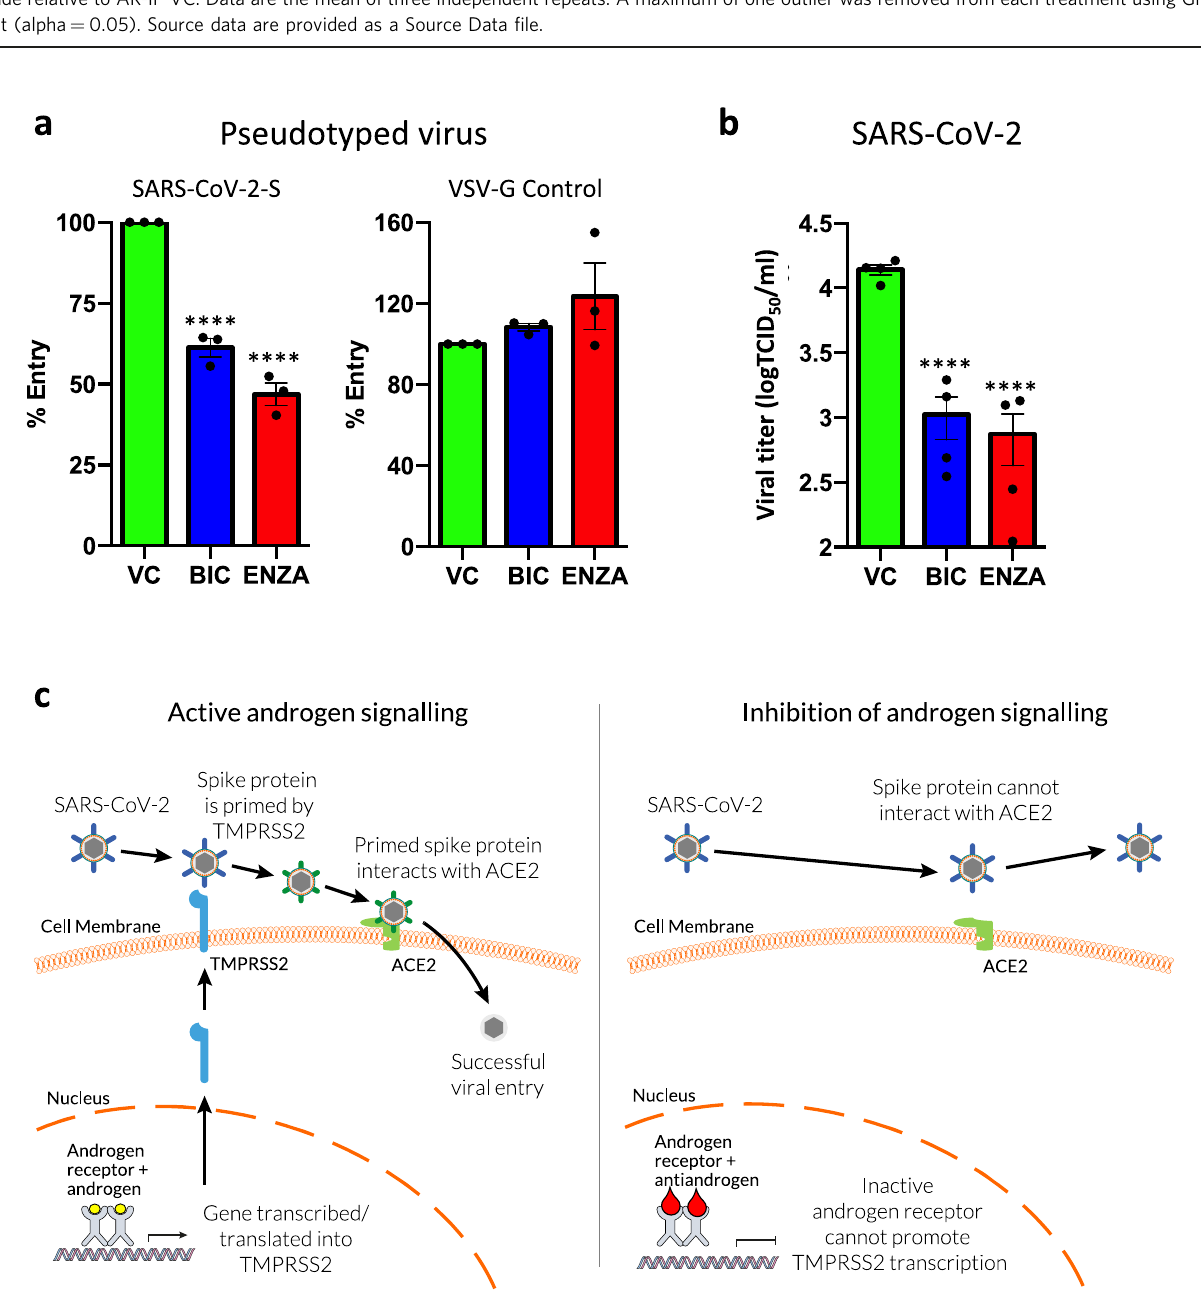
Fig. 7 Antiandrogens reduce SARS-CoV-2 entry and infection in lung cells. a A549 cells were seeded in full media and treated with ±10 μ M bicalutamide (BIC) or enzalutamide (ENZA) for 72 h prior to transduction with SARS-CoV-2 Spike protein or VSV-G control pseudotyped lentiviral particles expressing luciferase. Cells were left for an additional 48 h and luciferase assays performed. Luciferase data were normalised to total protein content. Mean of three independent repeats ± 1 SE. One-way ANOVA with Sidak ’ s multiple comparison test. Vehicle Control (VC) v BIC p = 1.3 × 10 − 4 , VC v ENZA p = 2.1 × 10 − 5 . b A549 were seeded in full media, transfected with ACE2 and treated with ±10 μ M BIC or ENZA for 72 h prior to infection with SARS-CoV-2. Infectious titres of SARS-CoV-2 in supernatants of A549-ACE2 were determined with TCID 50 assays after 24 h of infection. n = 4, mean of two independent experiments repeated in duplicate ± 1 SE. One-way ANOVA with Sidak ’ s multiple comparison test. VC v BIC p = 2.0 × 10 − 6 , VC v ENZA p = 2.5 × 10 − 6 . c Schematic representation of how targeting the AR could reduce SARS-CoV-2 entry. Source data are provided as a Source Data fi le.